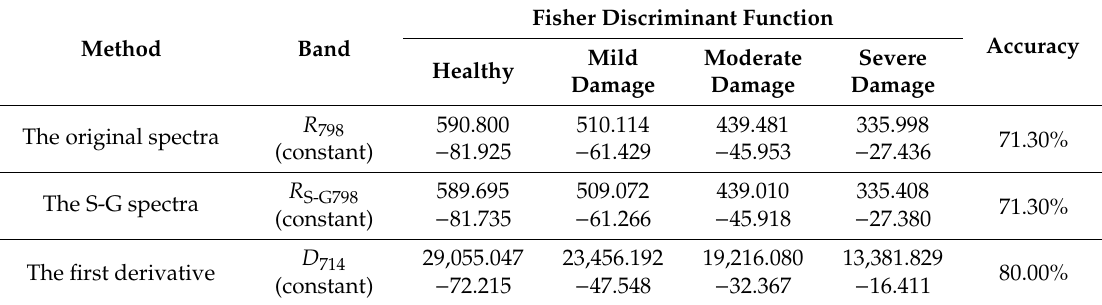
Table 7. Discriminant analysis results of di ff erent spectral processing